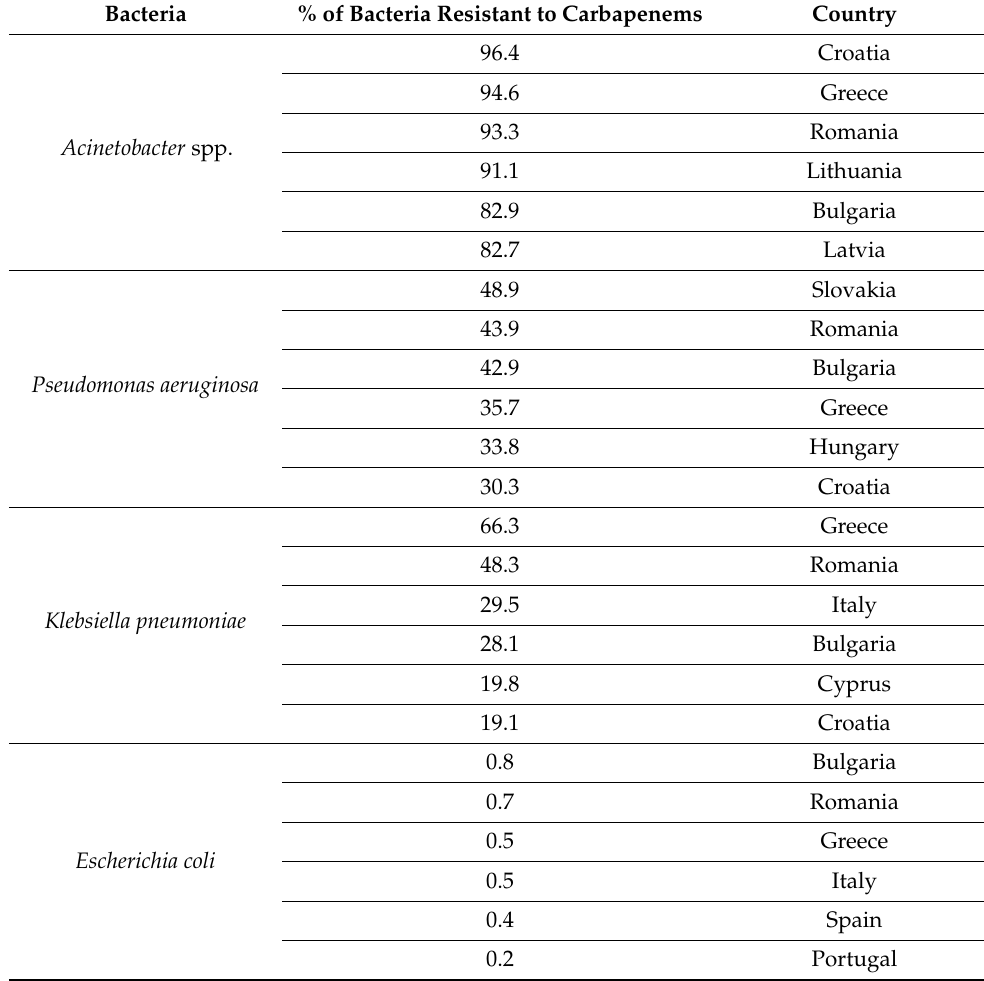
Table 2. European prevalence of critical priority bacteria that acquired carbapenem-resistance [6]. Bacteria % of Bacteria Resistant to Carbapenems Country